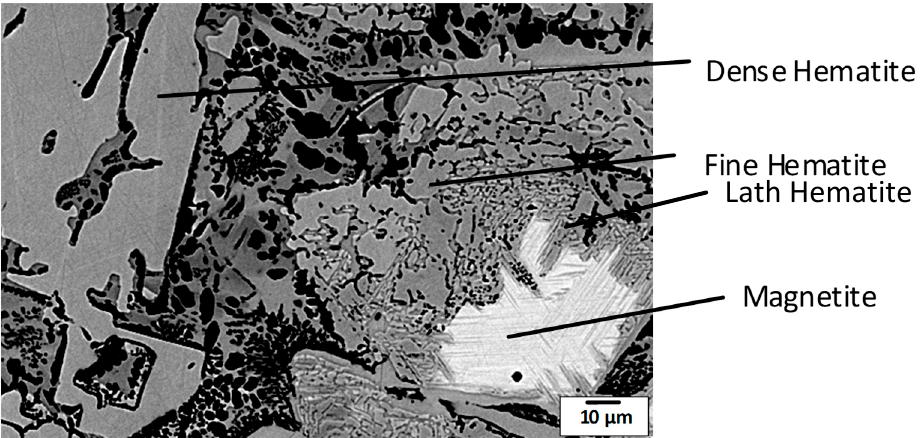
Figure 20. Magnetite and hematite microstructures formed when magnetite is cooled in air from 1673 K to 1073 K at 2 K/s in air (88 wt % Fe 2 O 3 and a CaO/SiO 2 ratio of 3.46 wt/wt).